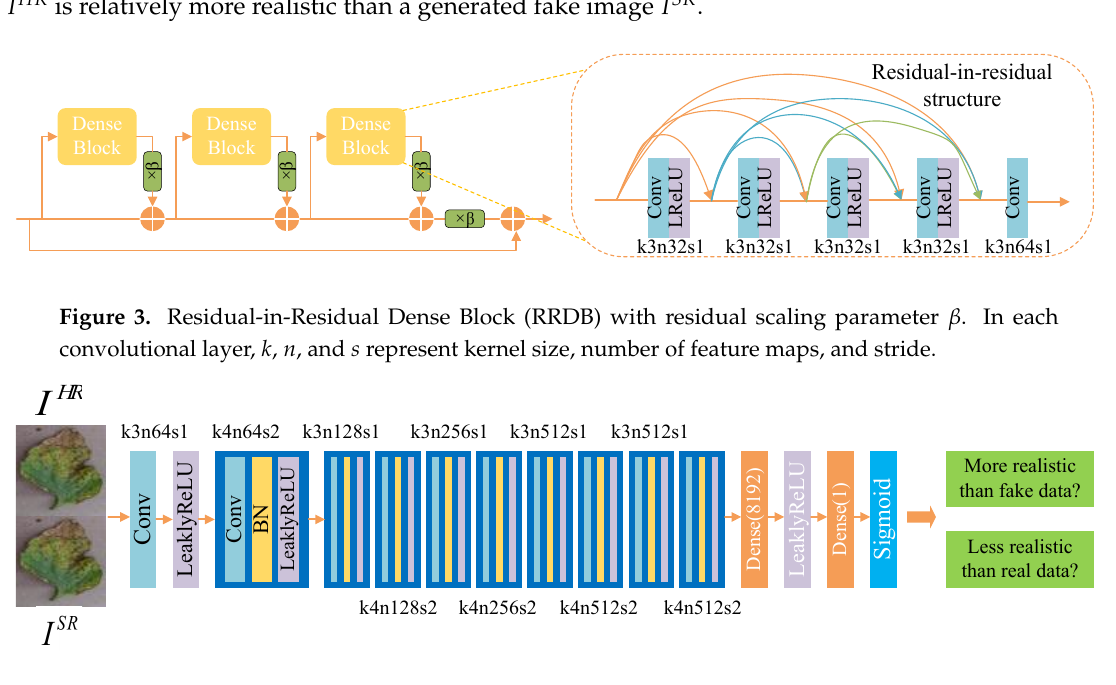
Figure 4. Architecture of discriminator network D Ra . In each convolutional layer, k , n , and s represent kernel size, number of feature maps, and